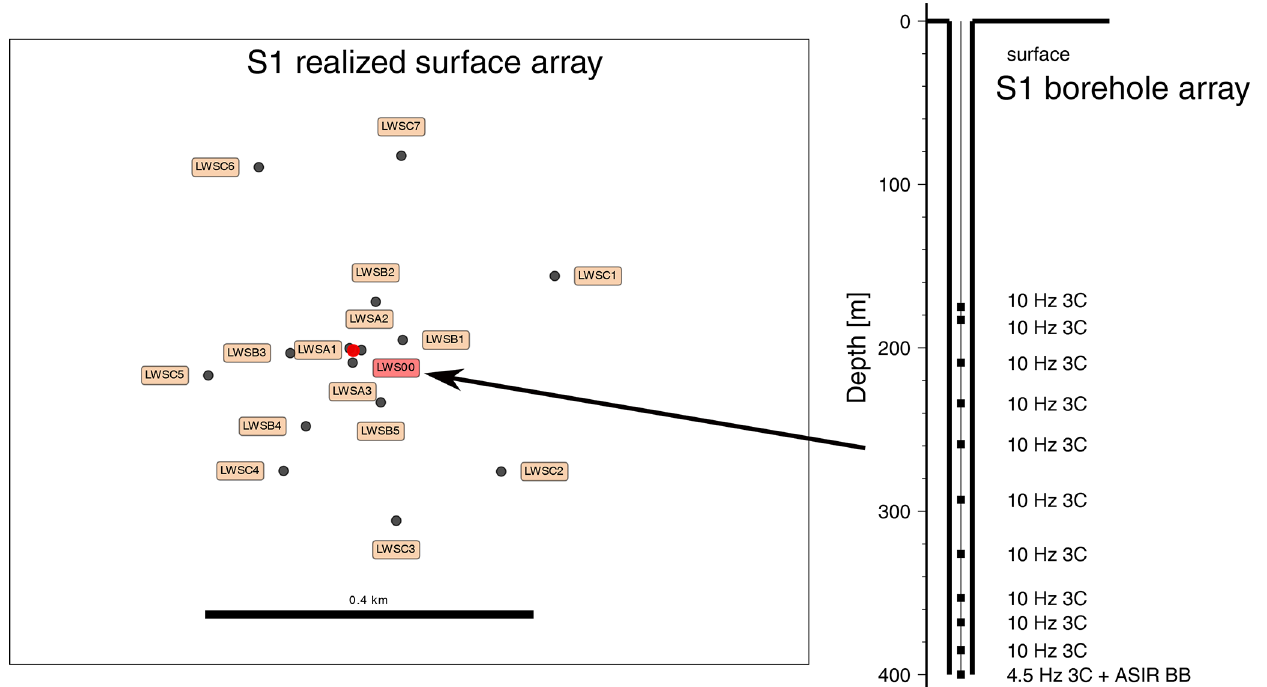
Figure 6. Surface and borehole 3-D high-frequency seismological arrays and the types of sensors realized at the S1 site. Red color denotes the S1 borehole with a surface